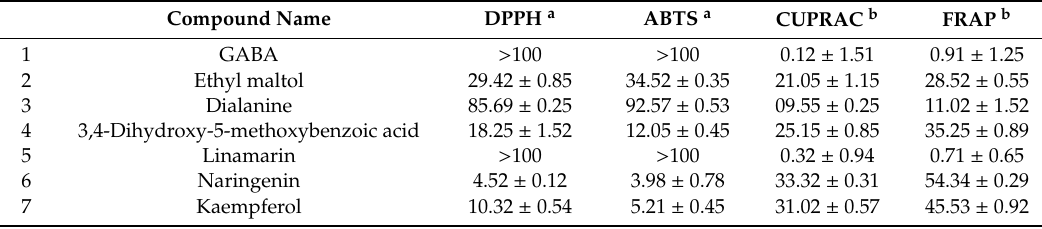
Table 2. Antioxidant activities of commercially available identified compounds from